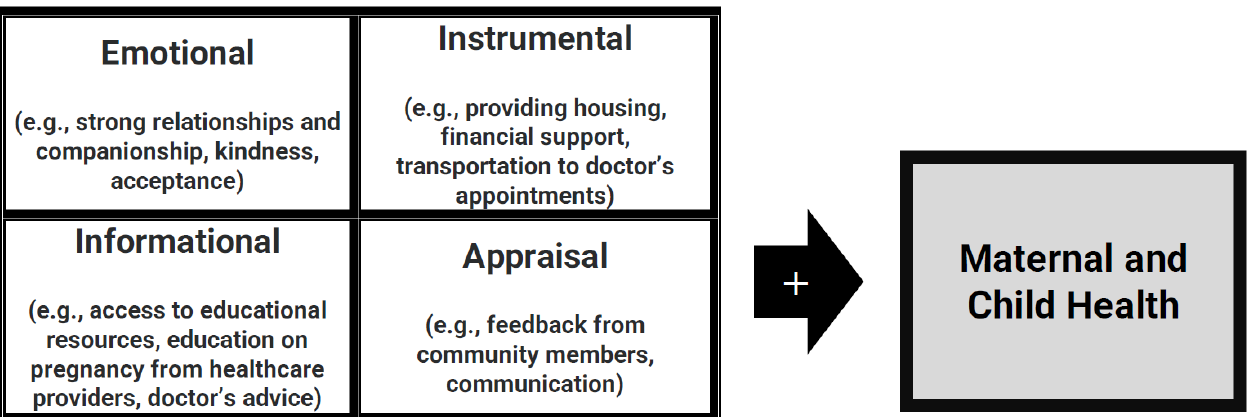
Figure 1. Conceptual framework based on House’s theory of social support (House,